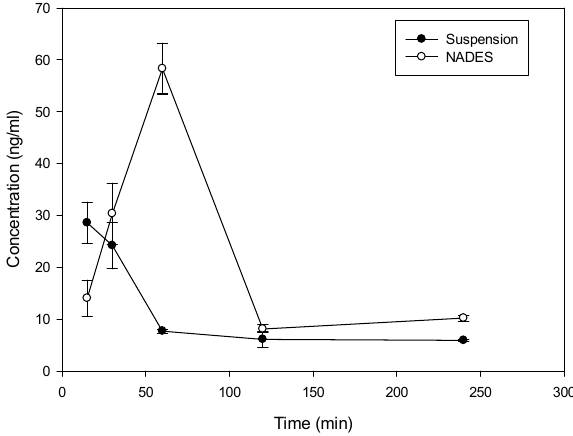
Figure 3. Time course (mean ± SD) of plasma concentration time course of rutin in Balb/c mice following oral administration of 10 mg as proline/glutamic NADES or suspension in water. Table 3. Non-compartmental pharmacokinetic parameters of rutin following oral administration in Balb/c mice (dose 10 mg).